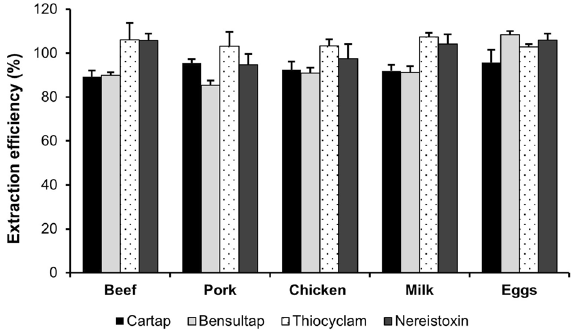
Figure 3. Extraction efficiencies of the nereistoxin insecticides and nereistoxin determined for an extraction solution containing 2% cysteine and 20 mM ammonium formate at pH